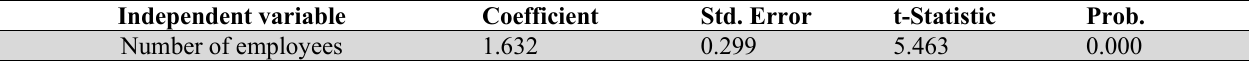
after tax Independent variable Coefficient Std. Error Number of employees